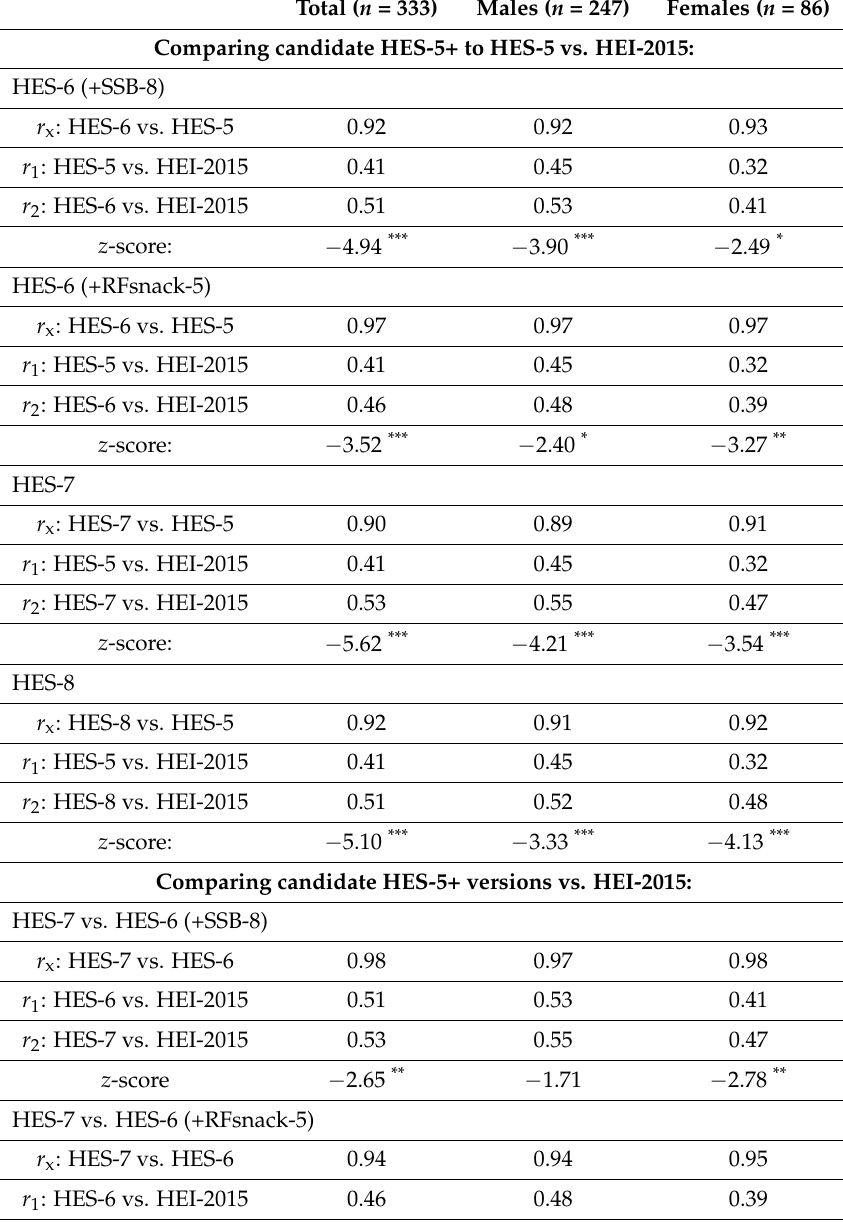
Table 3. A formal comparison of correlated correlation coefficients among CHAMP’s CSF military participants: HES-5 and HES 5+ vs. HEI-2015 ( n = 333) 1 . Total ( n = 333) Males ( n = 247) Females ( n = 86) Comparing candidate HES-5+ to HES-5 vs.